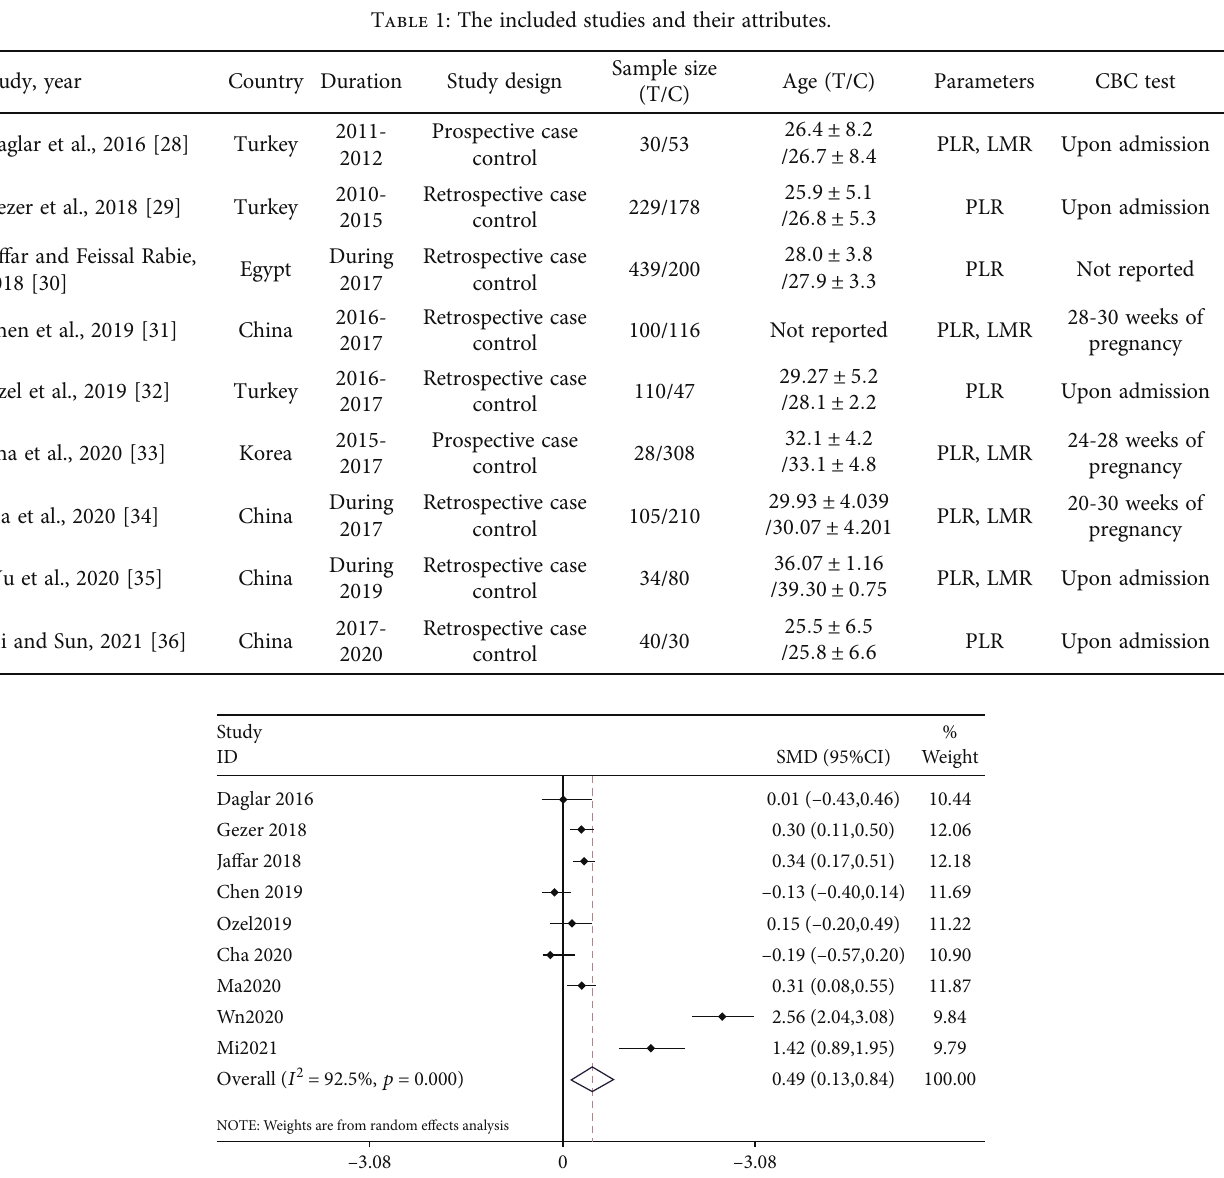
Figure 2: Forest plot of PLR levels in the spontaneous preterm birth group comparing to the control